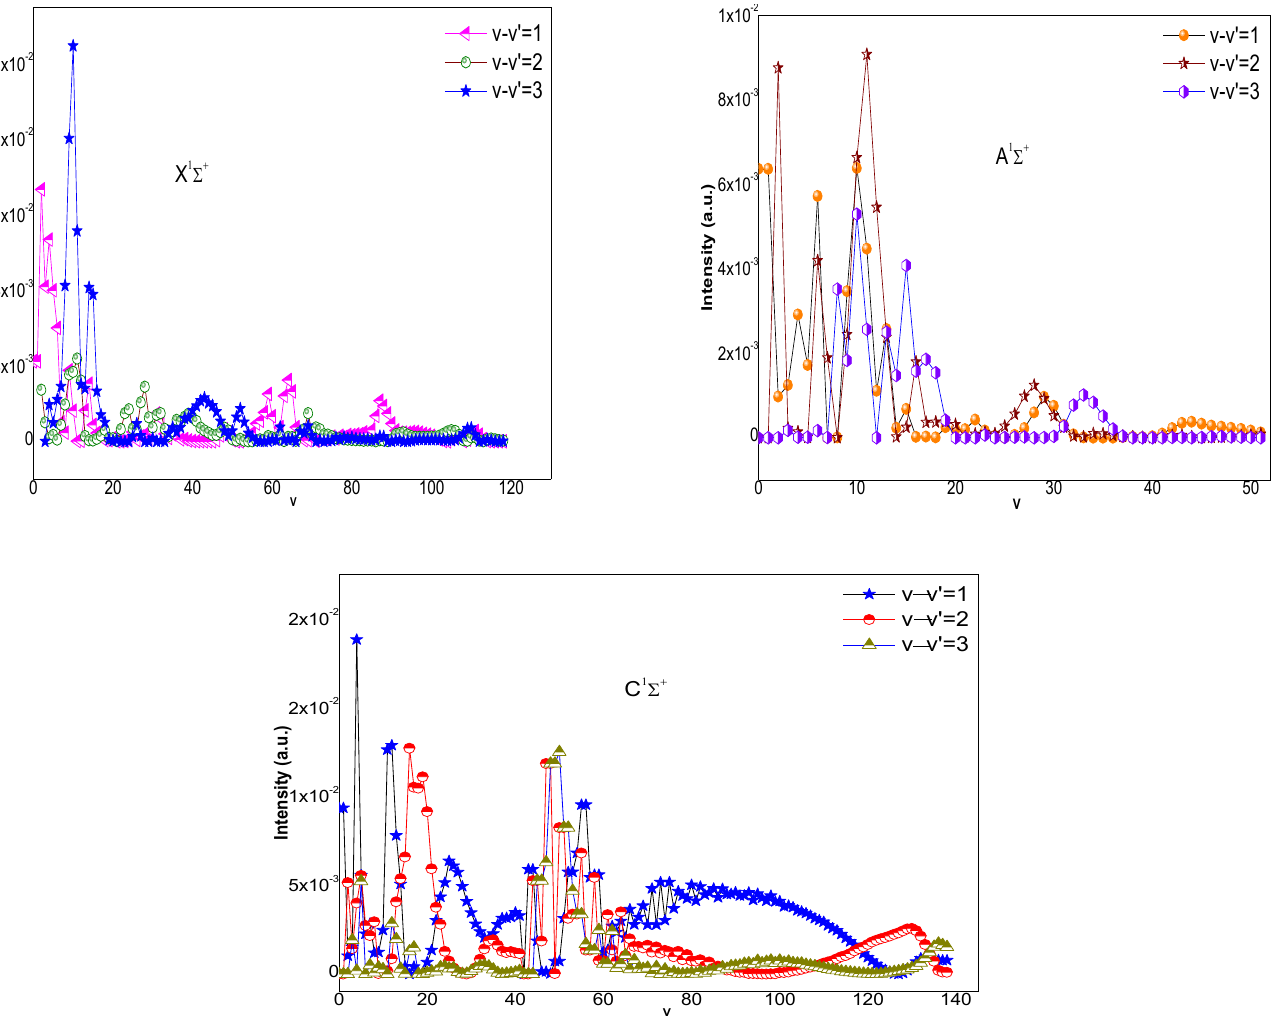
Figure 4. Transition between the non-neighboring vibrational states of the X, A and C of SrK + . We note that, contrary to the rules for the selection of the harmonic oscillator, we can have non-negligible transitions between non-neighboring vibrational levels [3,4], but the transitions between neighboring levels are generally greater.